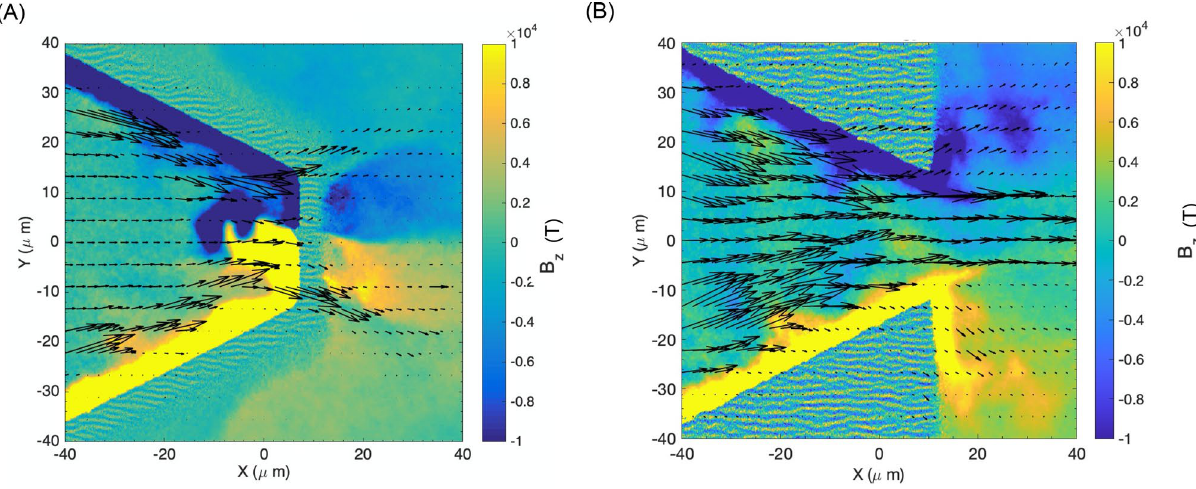
Figure 6. Map of the proton energy flux for free-standing and tip-less buried cone targets. ( A ) Proton energy flux superposed to the Bz map at 3.6 picoseconds in the simulation. It appears clear that the deflection of the proton beam occurs prior to reaching the tip due to the combined action of electric and magnetic field. ( B ) Proton energy flux superposed to the Bz map at 3.6 picoseconds in the simulation. It is evident that the majority of the protons exiting the cone tip are collimated by the azimuthal magnetic field structure and the consequent focusing electric